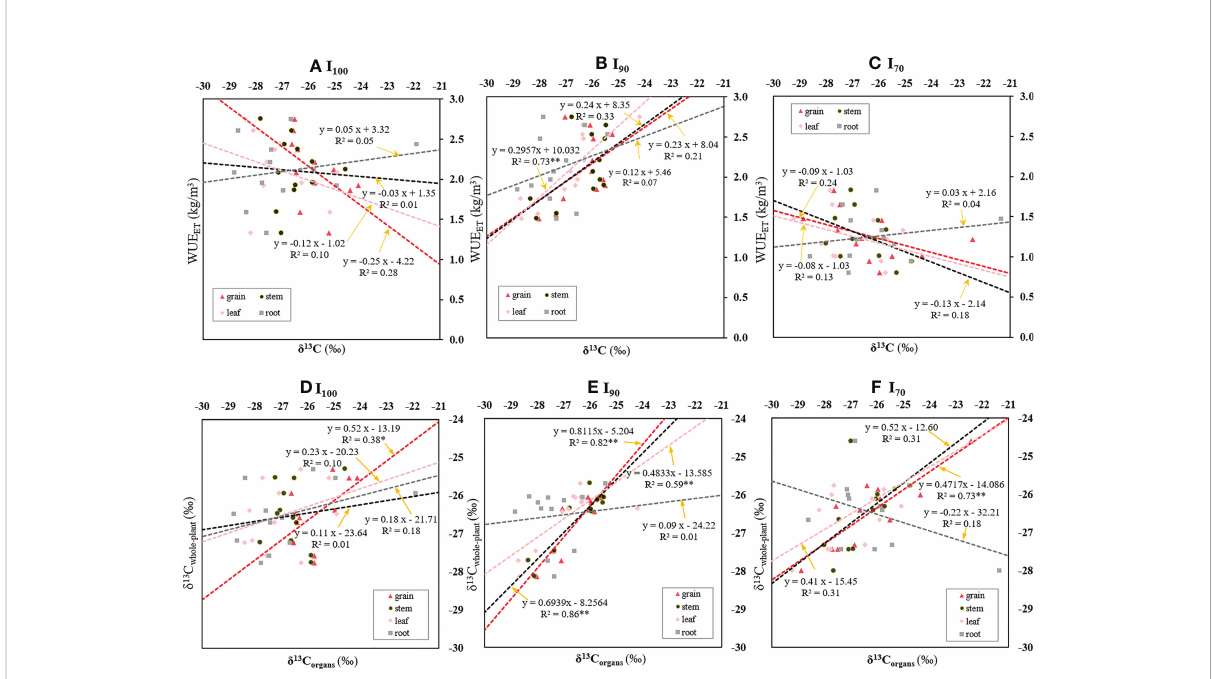
FIGURE 4 Relationships between WUE ET and carbon isotope composition of diverse rice organs ( d 13 C organs ) (A – C) ; and between d 13 C whole-plant and – F) as in fl uenced by different water regimes. *, ** and represent 0.01< p <0.05, and p <0.01, d 13 C organs (D